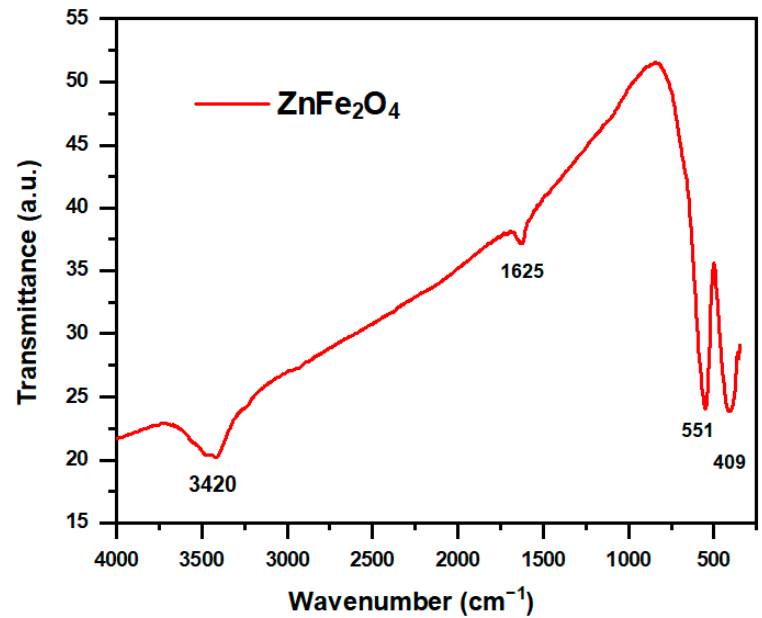
Figure 1. FTIR spectrum of ZnFe 2 O 4 (ZFNPs).